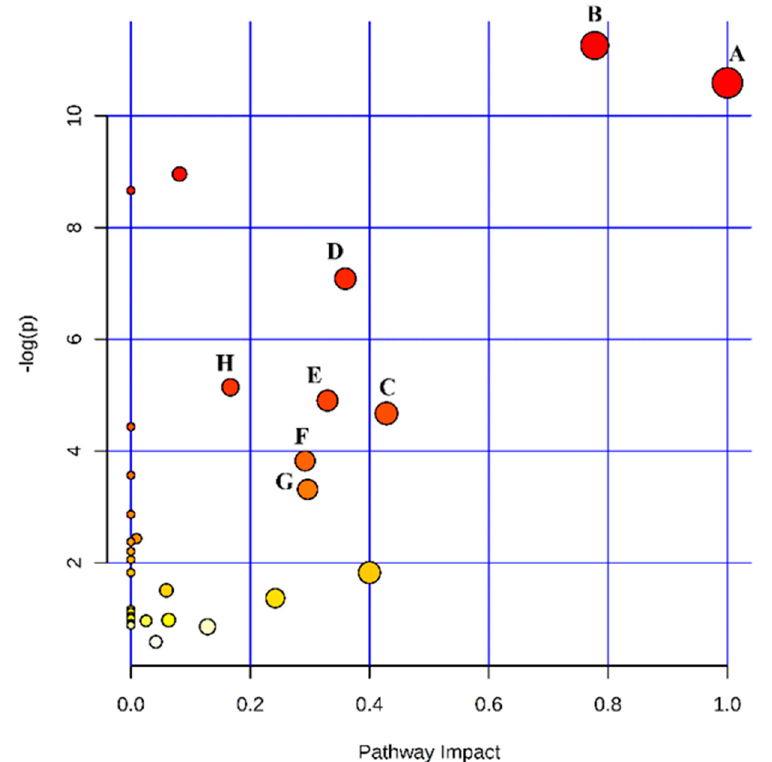
Figure5. Summaryofpathwayanalysis. Notes: A.Phenylalanine, tyrosineandtryptophanbiosynthesis; B. Phenylalanine metabolism; C. Taurine and hypotaurine metabolism; D. Tryptophan metabolism; E. Tyrosine metabolism; F. Glyoxylate and dicarboxylate metabolism; G. Glycine, serine and threonine metabolism; H. Citrate cycle (TCA